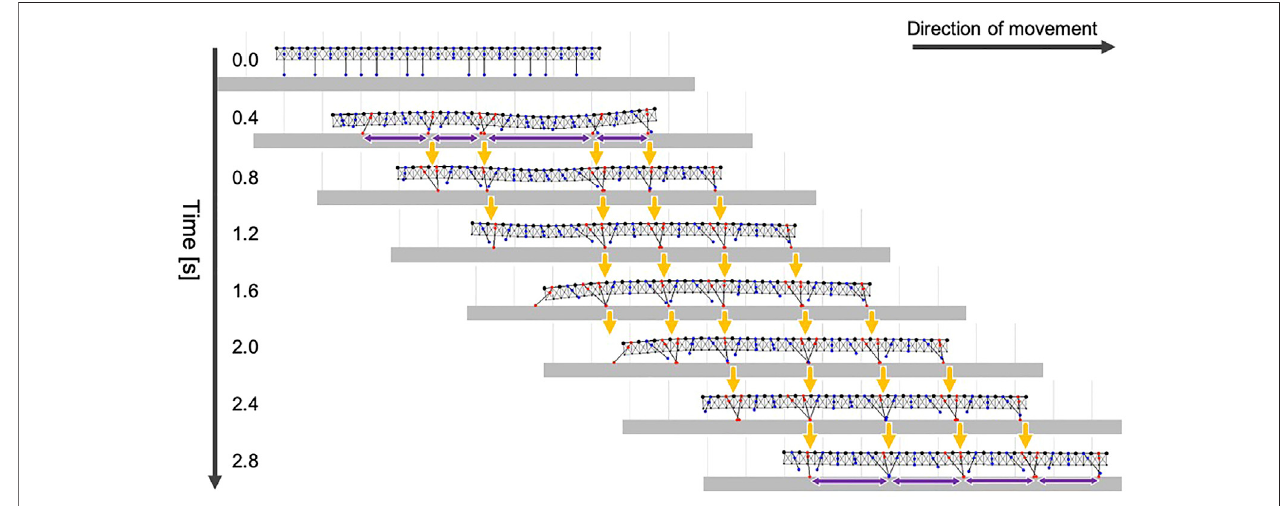
FIGURE 5 | Snapshots of the simulated centipede walking on fl at terrain using the proposed model. Orange arrows indicate that the ground contact points of the anterior legs were trailed by the posterior legs. Purple arrows denote the wavelength of the leg movements.